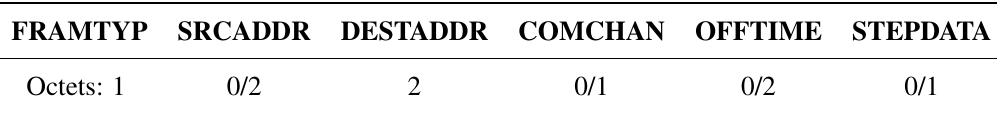
Table 1. General frame format. TSU, time slot unit.